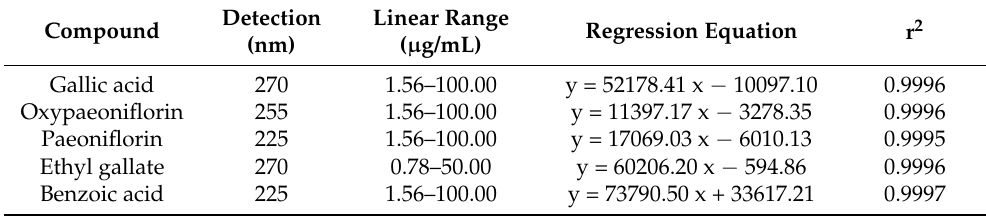
Table 1. Linear range, regression equation, and coefficient of determination (r 2 ) for marker